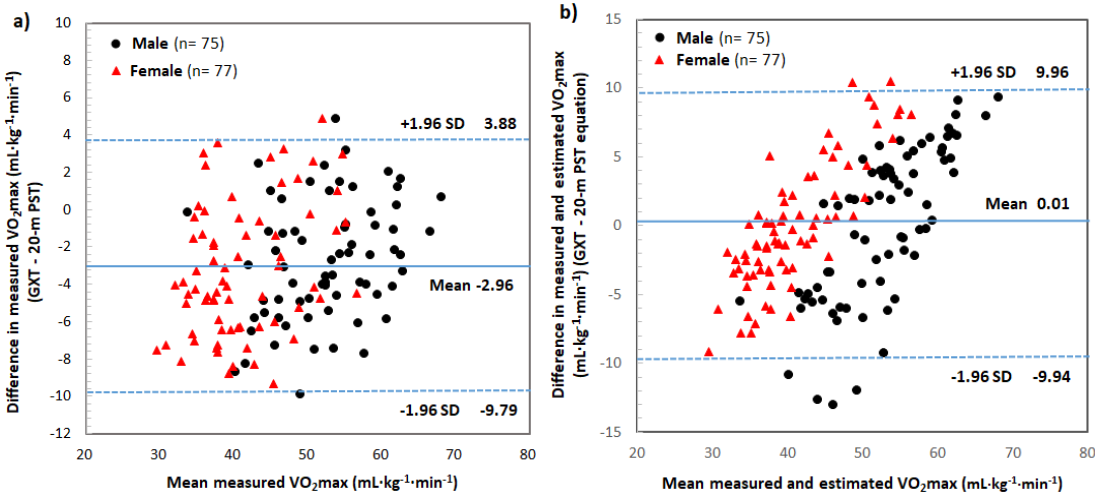
Figure 2. ( a ) Bland–Altman plot for the directly measured VO 2max from the GXT and from the modified 20 m PST. ( b ) Bland–Altman plot for the directly measured VO 2max and estimated VO 2max from the new equation. The solid line represents the mean difference (bias) in the VO 2max measured from the GXT and that measured from the modified 20 m PST. The upper and lower broken lines represent the 95% limits of agreement (mean difference ± 1.96 SD of the difference).